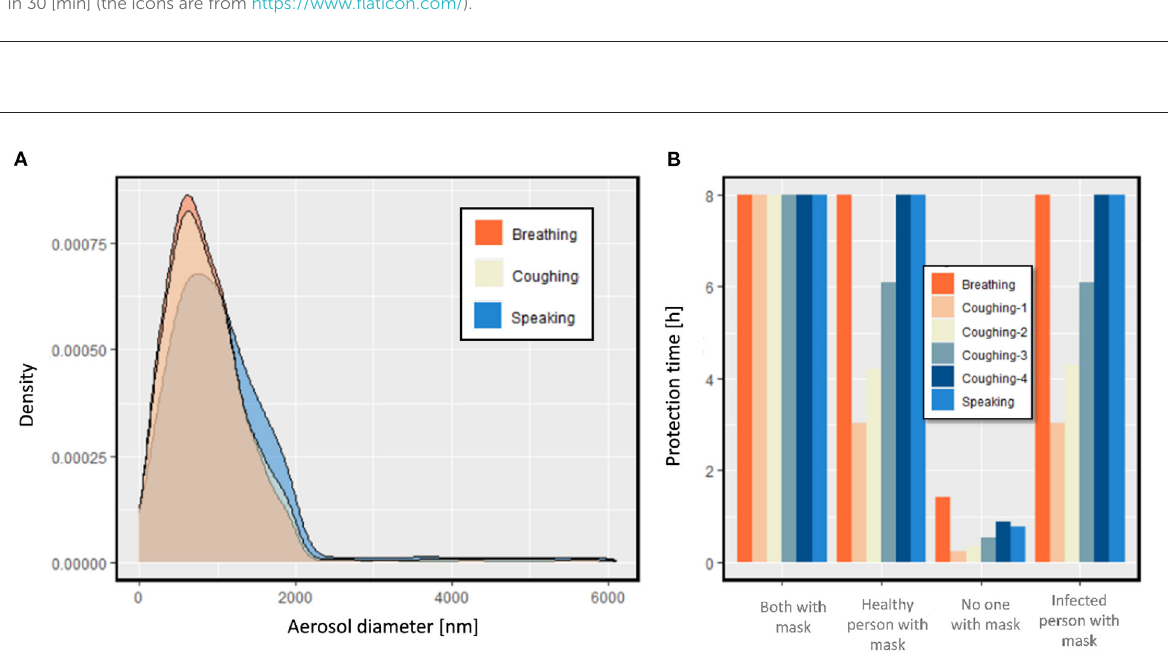
FIGURE6 (A) Diameter distribution of exhaled aerosols by the infected person during breathing, speaking, and coughing, (B) protection time for a healthy person in an office